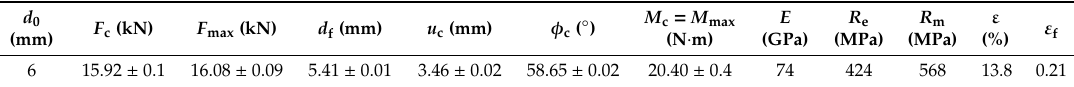
Table 2. Values of the basic strength parameters of the ENAW_2024-T351 aluminum alloy and critical values of stress and